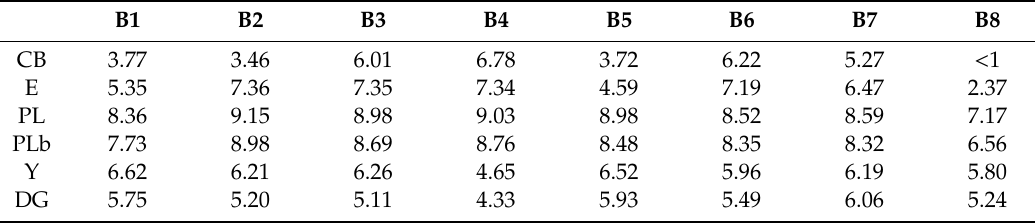
Table 3. Microbiological quality of bryndza cheeses (values of geomean) (log CFU /